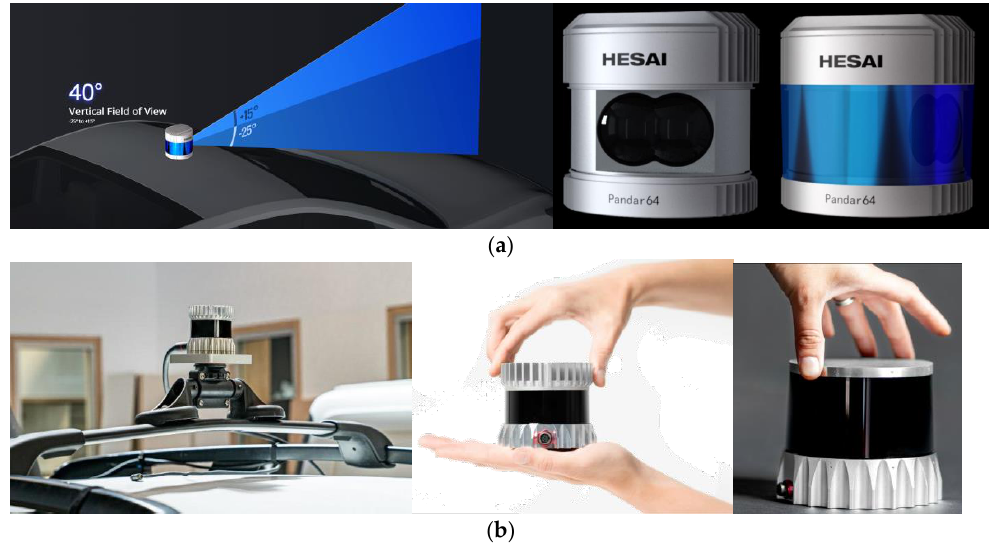
Figure 1. ( a ) Pandar64 [11]. ( b ) Ouster Lidar types [13,15].